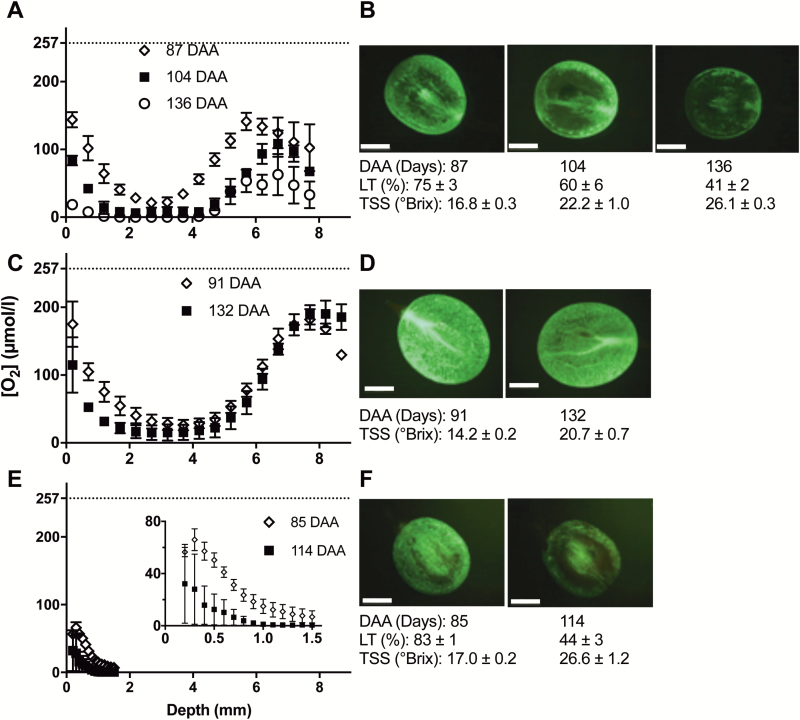
[O2] profiles of Chardonnay, Ruby Seedless, and Shiraz berries (A, C, E) at various ripening stages and corresponding examples of living tissue (LT) in the pericarp for each variety (B, D, F). (A) Chardonnay berries were sampled at 87, 104, and 136 DAA in the 2015–2016 season. Two-way ANOVA (repeated) showed that depth accounted for 46.7% of total variation (P<0.0001), time accounted for 29.9% of total variation (P<0.0001), and interaction accounted for 8.0% of total variation (P=0.058). The horizontal dashed line indicates the approximate O2 saturation value for Millipore water at room temperature, the same as berries at the time of measurement. (B) Medial longitudinal sections (Chardonnay) stained with FDA, highlighting LT differences at different stages of ripening (corresponding to A). (C) [O2] profiles of Ruby Seedless berries sampled at 91 and 132 DAA in the 2016–2017 season. Two-way ANOVA (repeated) showed that depth accounted for 85.2% of total variation (P<0.0001), time accounted for 1.2% of total variation (P=0.0025), and interaction accounted for 3.7% of total variation (P=0.048). (D) LT of Ruby Seedless was close to 100% for the two respective sampling days. (E) [O2] profiles of Shiraz berries sampled on 85 and 114 DAA in the 2014–2015 season. Inset shows detail of the profile to 1.5 mm. Two-way ANOVA (repeated) showed that depth accounted for 40.9% of total variation (P=0.0005), time accounted for 19.6% of total variation (P<0.0001), and interaction accounted for 6.4% of total variation (P=0.43). (F) LT of Shiraz. Data are means ±SE, n=3 for (A), (C), and (E).